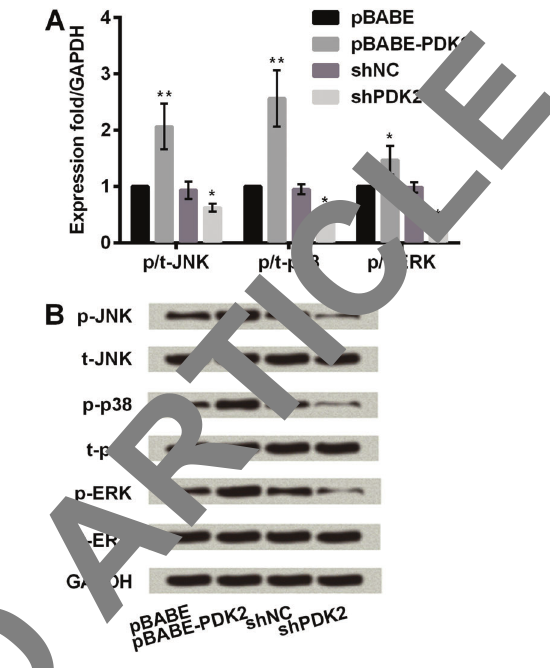
Figure 4. PDK2 upregulation of JNK/MAPK/ERK signaling pathway in mesenchymal stem cell. PDK2: pyruvate dehydro- genase kinase isoform 2; sh: short hairpin; NC: negative control; JNK: c-Jun N-terminal kinase; ERK: extracellular regulated protein kinase; GAPDH: glyceraldehyde-3-phosphate dehydro- genase. *P o 0.05; **P o 0.01 compared with pBABE or shNC group